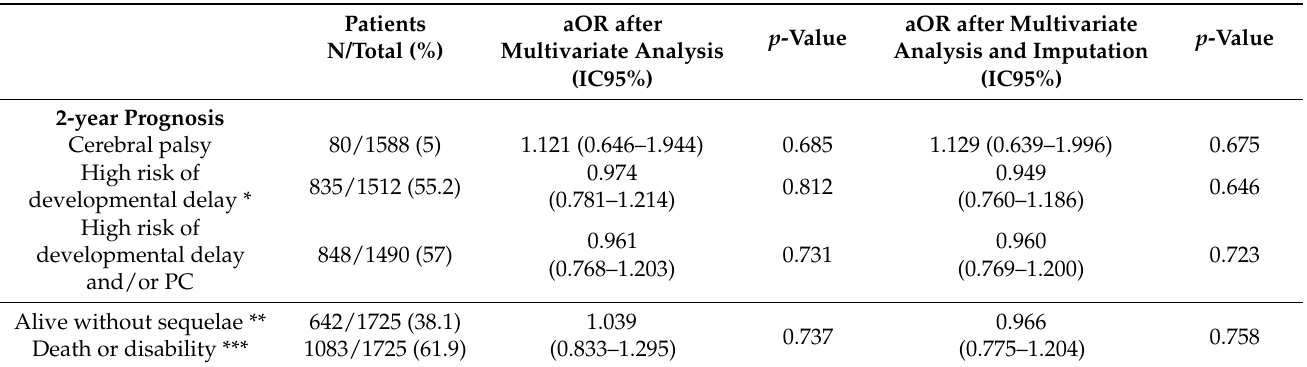
Table 3. Correlation between the hemoglobin value at birth (hemoglobin threshold at 15.2 g/dL) and 2-year prognostics for infants born <32 weeks.